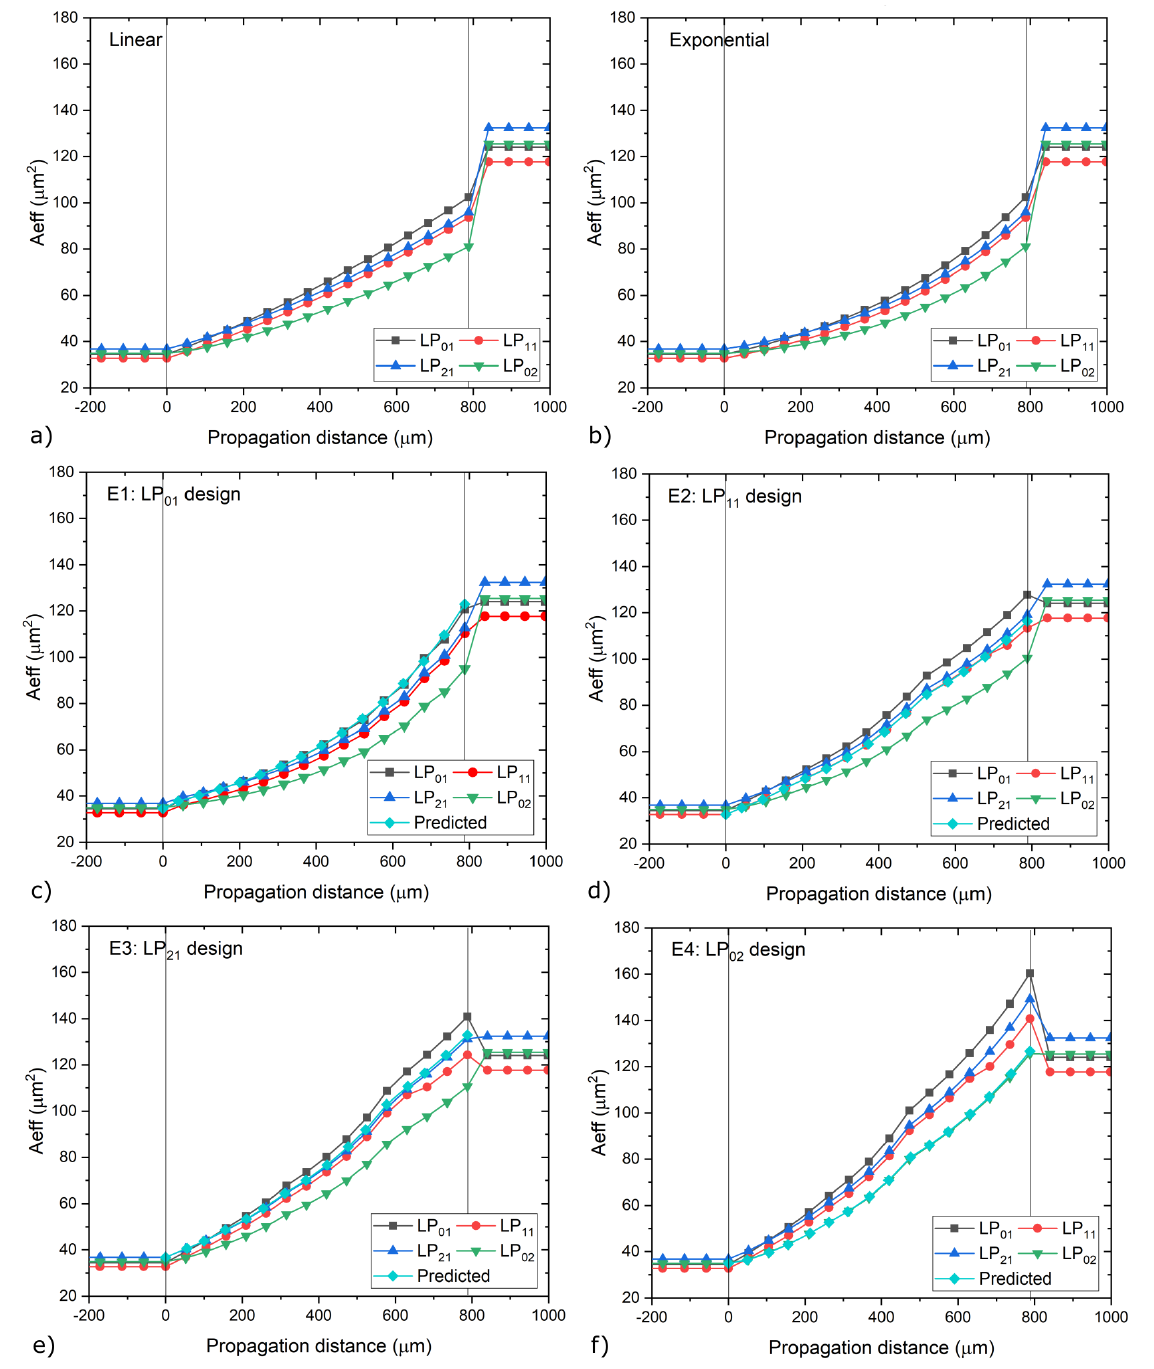
Figure 6. Modal propagation conditions in the different MFA profiles: ( a ) linear, ( b ) exponential and optimized profiles for: ( c ) E1 for LP 01 , ( d ) E2 for LP 11 , ( e ) E3 for LP 21 and ( f ) E4 for LP 02 . Vertical lines indicate the boundaries of the PIC waveguide and